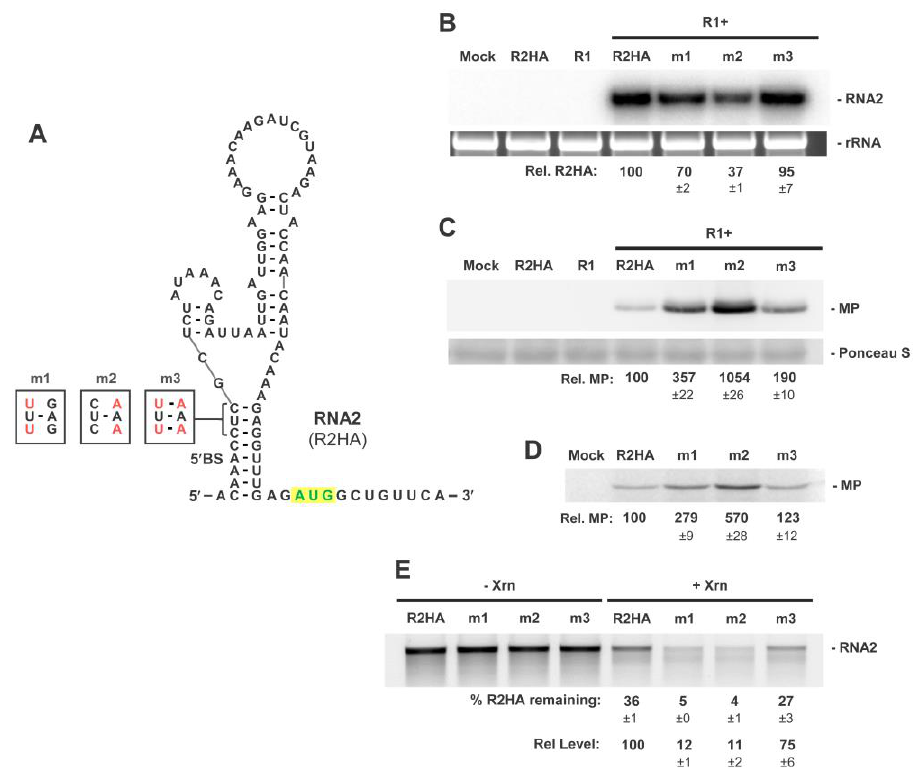
Figure 3. RNA2 5 (cid:48) UTR mutants testing 5 (cid:48) BS function. ( A ) RNA secondary structure of the 5 (cid:48) UTR of RNA2 showing positions of double-nucleotide substitutions designed to inhibit or promote base pairing in the 5 (cid:48) BS. Nucleotide substitutions are shown in red. ( B ) Northern blot analysis of protoplast infections with wt RNA1 (R1) and RNA2 mutants. The position of RNA2 is denoted on the right-hand side along with rRNA loading controls. Relative levels of genome accumulation compared to R2HA (set at 100) are shown with SEMs (n = 3). ( C ) Corresponding Western blot analysis of protoplast infections depicted in panel ( B ). The position of the MP is denoted on the right-hand side along with Ponceau S staining loading controls. Relative levels of MP accumulation normalized to corresponding RNA levels, with that for R2HA set at 100, are shown with SEMs (n = 3). ( D ) In vitro translation in wheat germ lysate of R2HA and mutants. Relative levels of MP accumulation compared to R2HA (set at 100) are shown with SEMs (n = 3). ( E ) In vitro Xrn1 treatment of R2HA and mutants. Percentages of input RNA remaining (% remaining) and relative levels (Rel. levels) of RNA remaining compared to R2HA (set at 100) are shown with SEMs (n = 3).